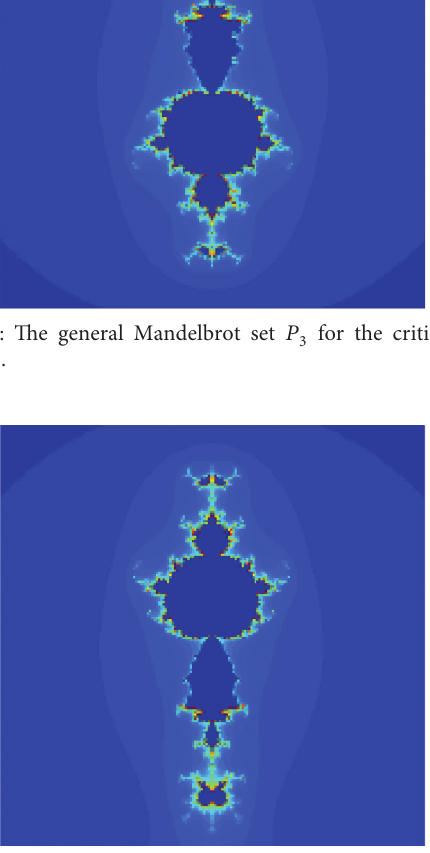
for the critical point 3